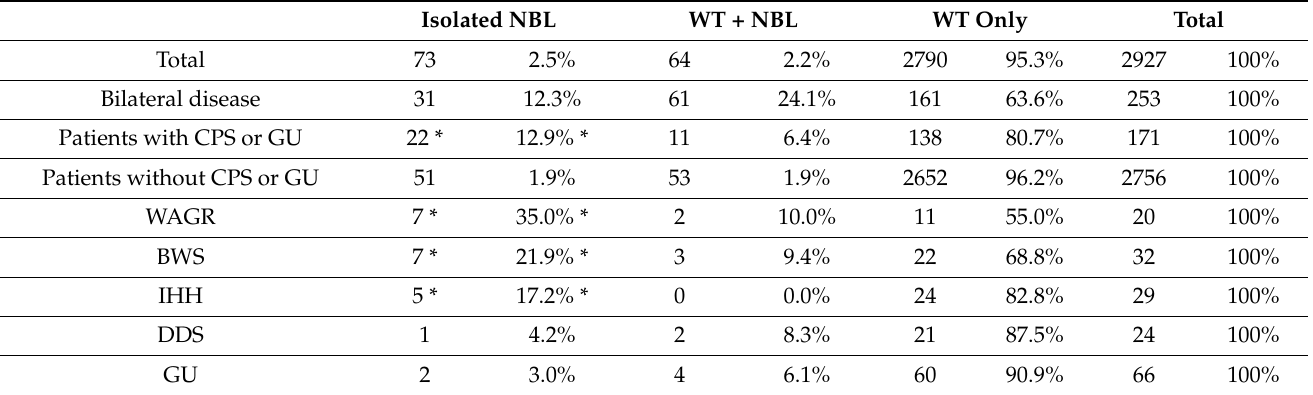
Table 2. Association between nephroblastomatosis (NBL) and CPS or malformation in the whole cohort of patients and bilateral disease; * chi-square p ≤ 0.001. WT: Wilms tumor; CPS: cancer predisposition syndrome; NBL: nephroblastomatosis; GU: Genitourinary malformations; BWS: Beckwith-Wiedemann spectrum; IHH: isolated hemihypertrophy; DDS: Denys- Drash syndrome; WAGR: Wilms tumor, aniridia, genitourinary abnormalities, range of developmental delays.